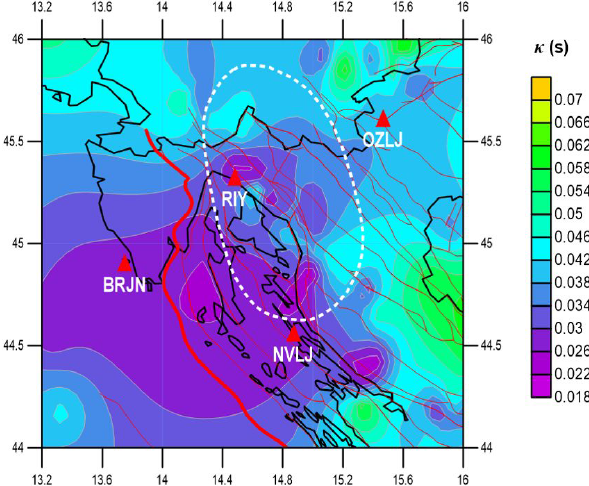
Figure 6. Regional κ dependence around each seismological station shown as a spatial distribution of individual κ values and plotted us- ing the nearest-neighbour interpolation method. The red lines rep- resent the possible seismogenic surface faults in Croatia as well as Bosnia and Herzegovina (Ivanˇci´c et al., 2006). The locations of the seismic stations are marked with red triangles. A thick white dashed line marks the contours of the northern Dinaric (ND) fast-velocity anomaly (Šumanovac and Dudjak, 2016). The thick red line marks the boundary between the External Dinarides (NE) and the Adriatic foreland